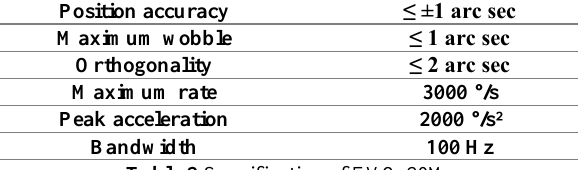
Table 2 .Specification of EVO-20M